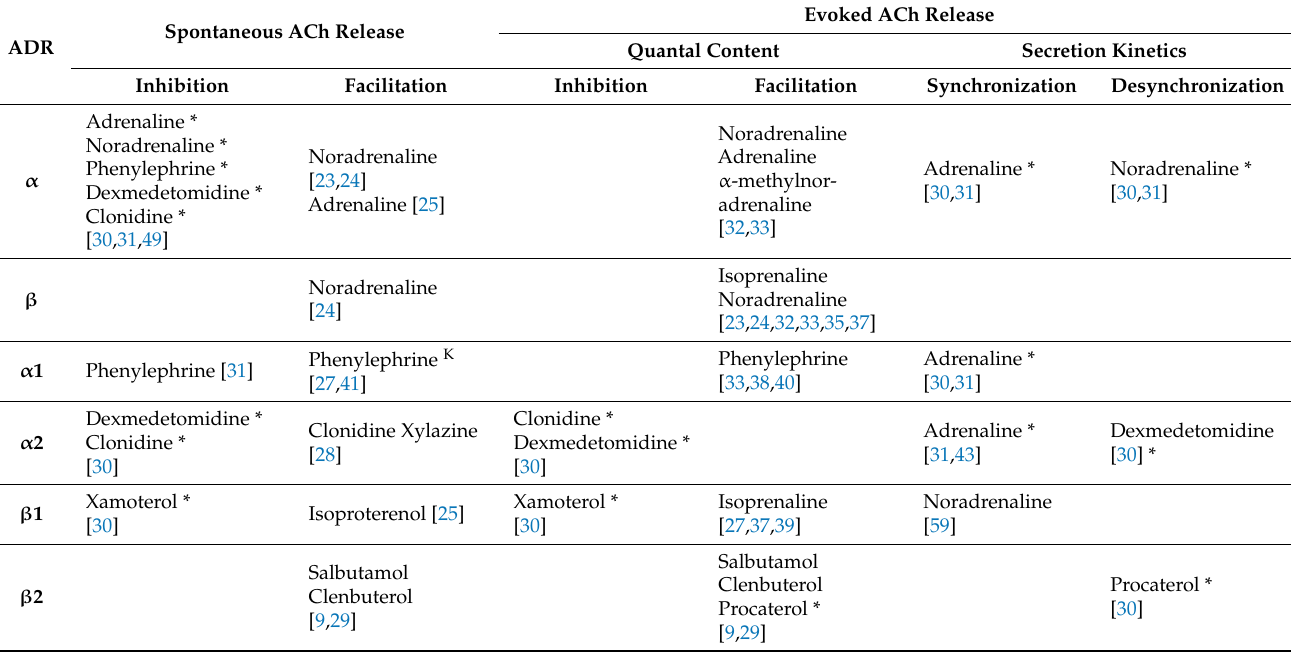
Table 1. Effects of agonists of various types of adrenergic receptors on the quantal ACh